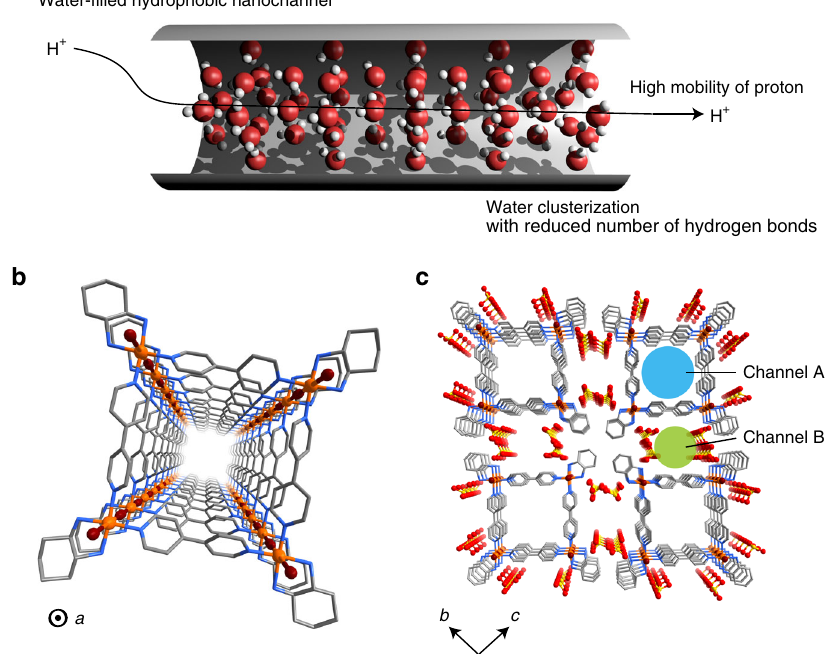
Fig. 1 Proton-conducting hydrophobic nanochannel. a Schematic illustration of a water- fi lled hydrophobic nanochannel. b The four-legged tubular structure of 1 viewed along the a -axis (100 K). Counter anions and water molecules have been omitted for clarity. c The packing structure of 1 in the bc plane. Channel A and channel B are highlighted by light blue and light green circles, respectively. Water molecules are omitted for clarity. Platinum, bromine, sulfur, carbon and nitrogen are represented by orange, brown, yellow, grey and blue spheres,